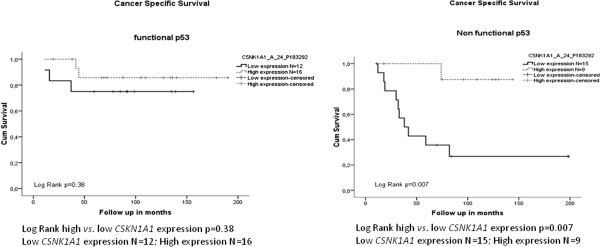
Kaplan Meier plots for CSS according to CSNK1A1 expression stratified on the base of p53 functionality.